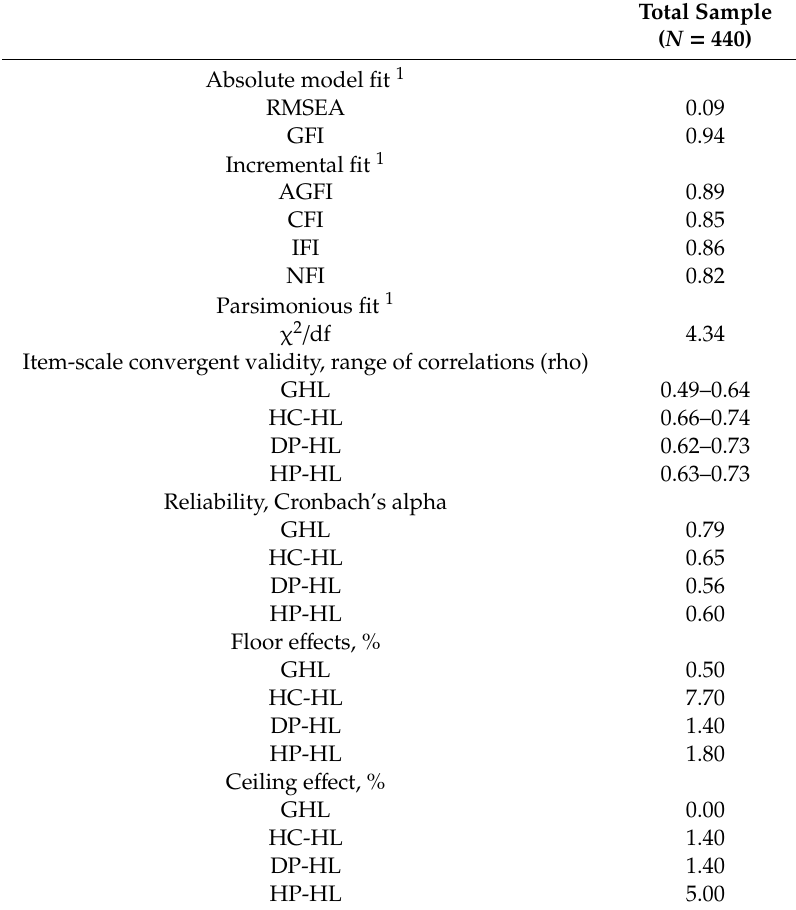
Table 2. Goodness-of-fit indices, item-scale convergent validity, internal consistency reliability, and floor / ceiling e ff ects of the